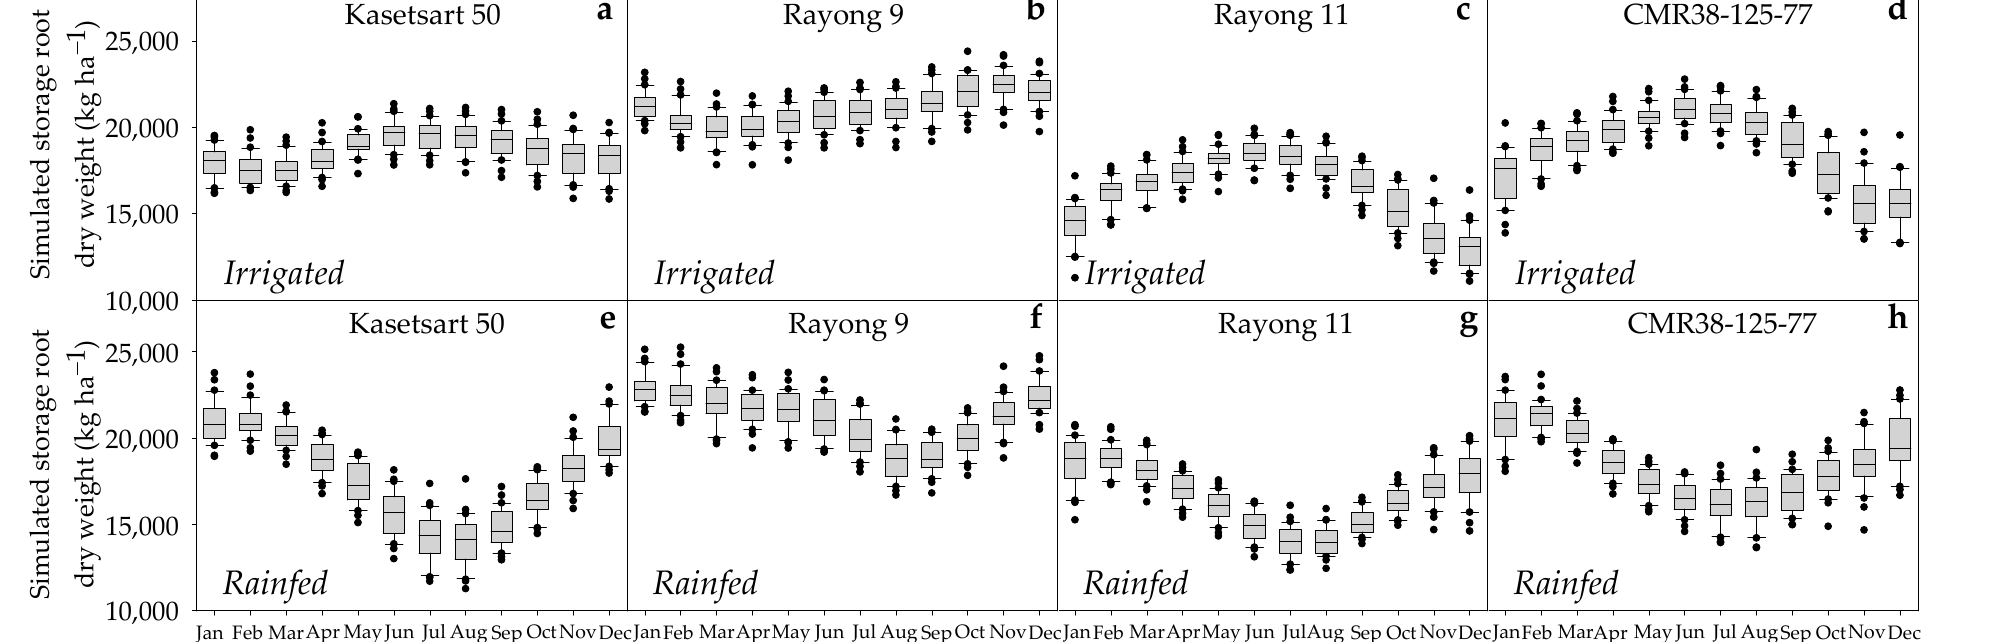
Figure 4. Means over ten locations and 30 years (1988–2018) of simulated storage root dry weight for Kasetsart 50, Rayong 9, Rayong 11, and CMR38–125–77 at 12 different planting dates and under irrigated ( a – d ) and rainfed conditions ( e – h ). Box limits represent the 25th and 75th percentiles; box central line represents the median and the outliers represent the minimum and maximum values.